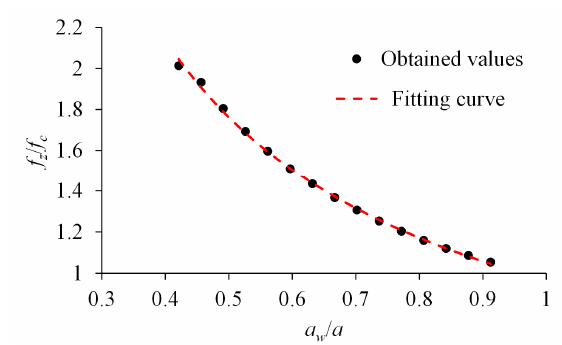
Figure 5. Simulated resonant frequency f z variation as a function of the iris width a w .